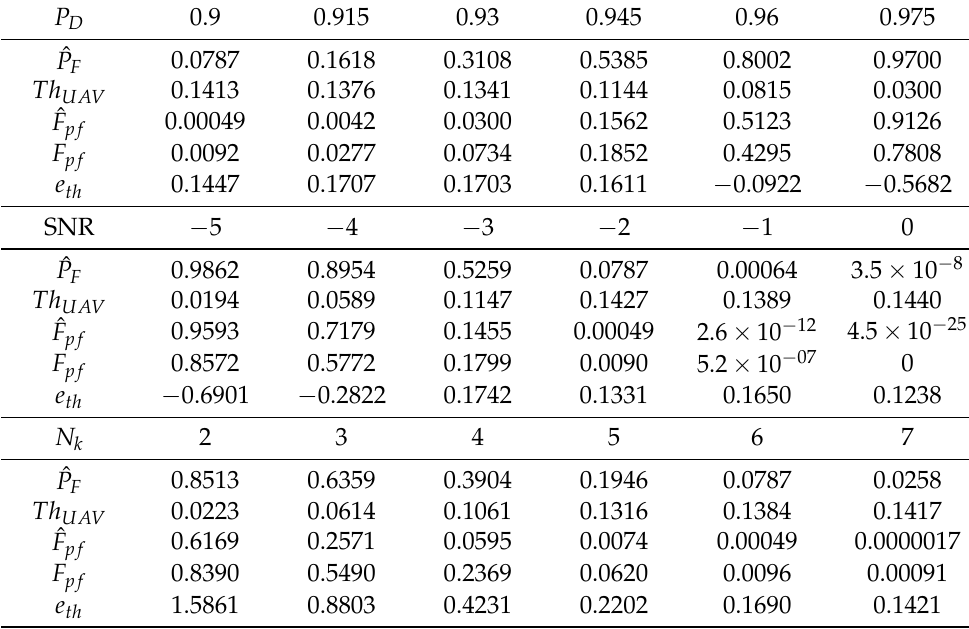
Table 6. Sensitivity table of performance to spectrum sensing